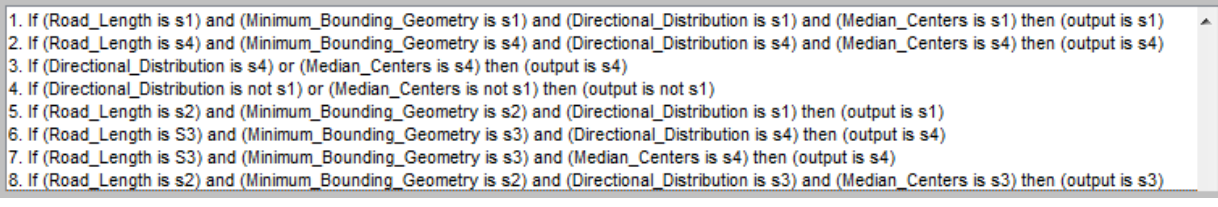
Figure 10. A number of defined rules in inference system.